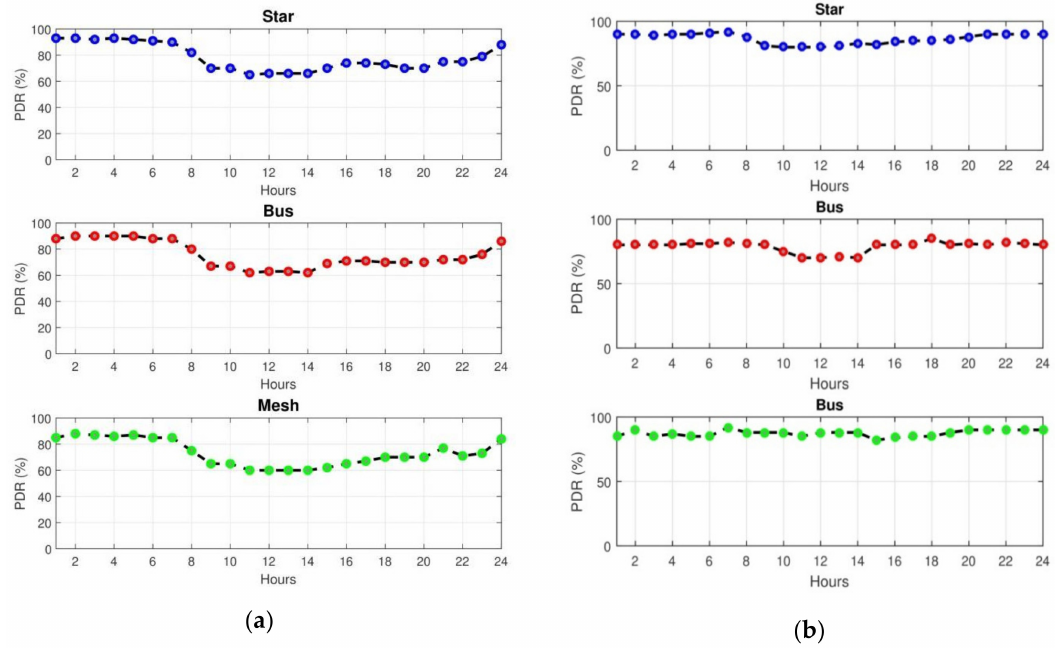
Figure18. PacketDeliveryRatioforstar, bus, andmeshtopologiesfor( a )WiFiand( b